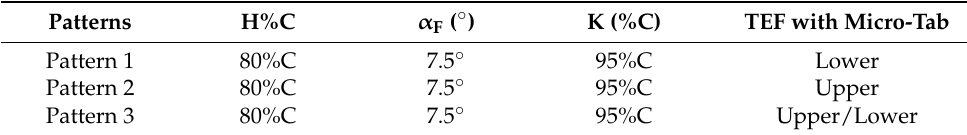
Figure 2. Geometrical parameters ( a ) of Trailing Edge Flap (TEF), ( b ) of Trailing-Edge Flap with Micro-Tab (TEF with Micro-Tab). Table 1. The parameters of the airfoil with TEF with